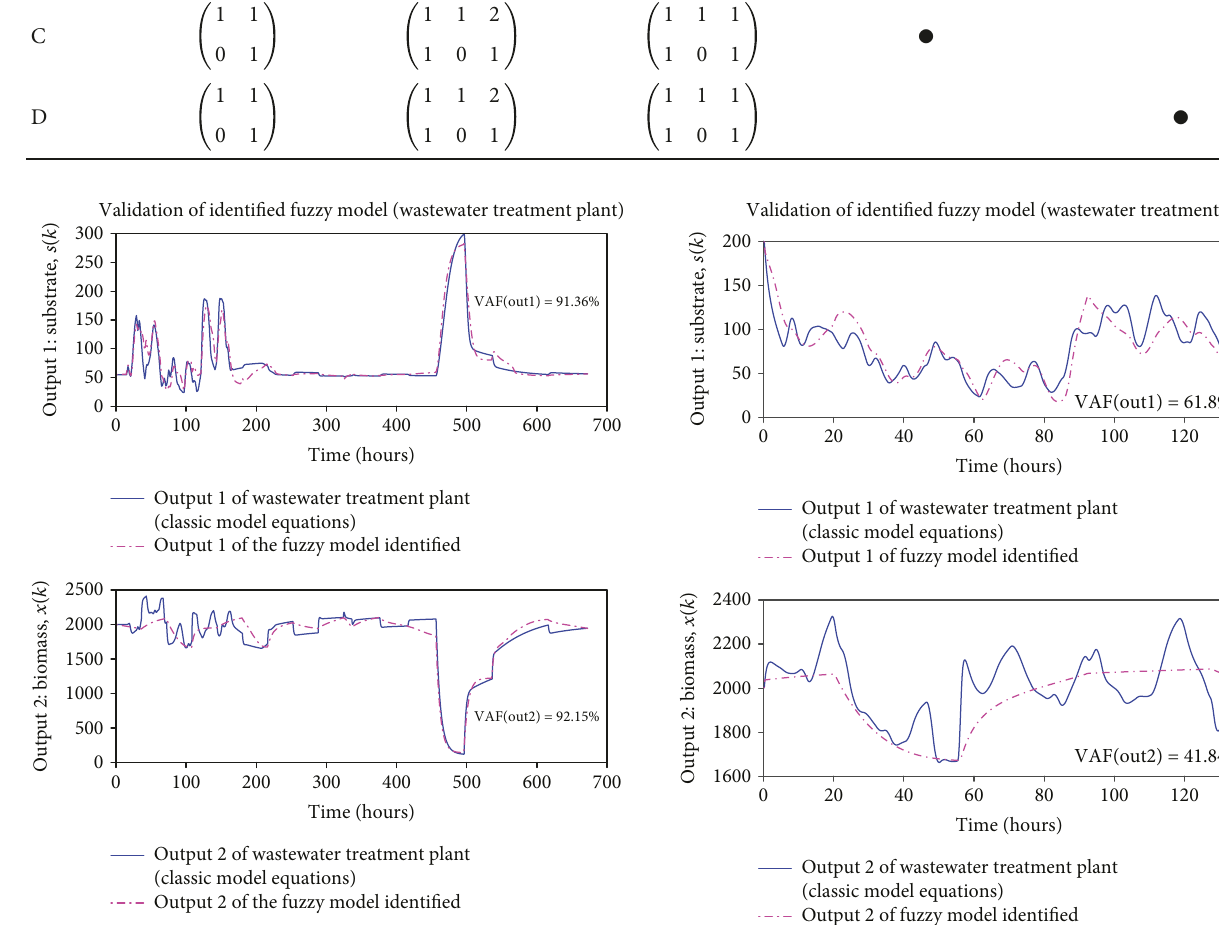
Figure 7: Validation of the identi fi ed fuzzy model corresponding to case A for output 1, s k , and output 2, x k .